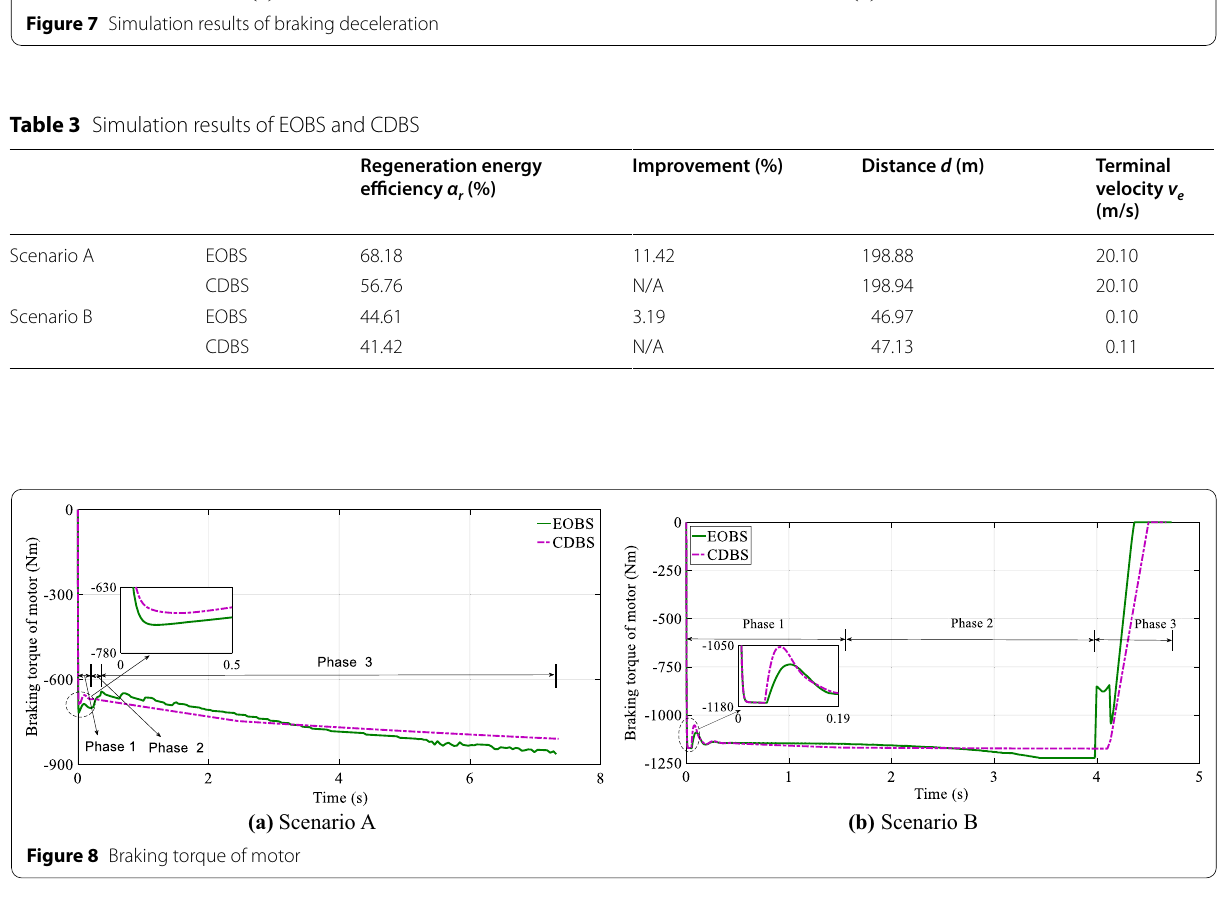
Figure 7 Simulation results of braking deceleration